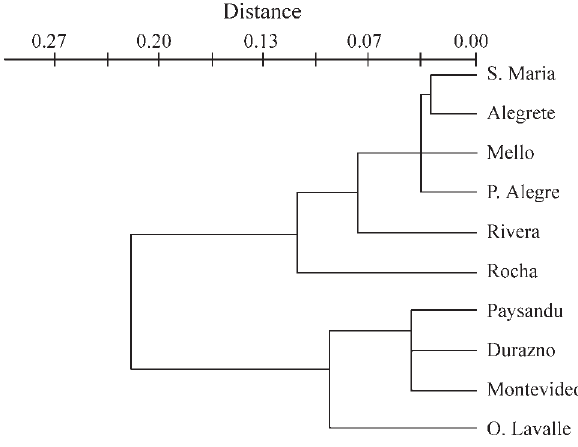
Figure 2 - Clustering analysis of genetic distances (Cavalli-Sforza and Edwards, 1967) among Africanized honeybee populations from southern Brazil and Uruguay using the UPGMA method of clustering.